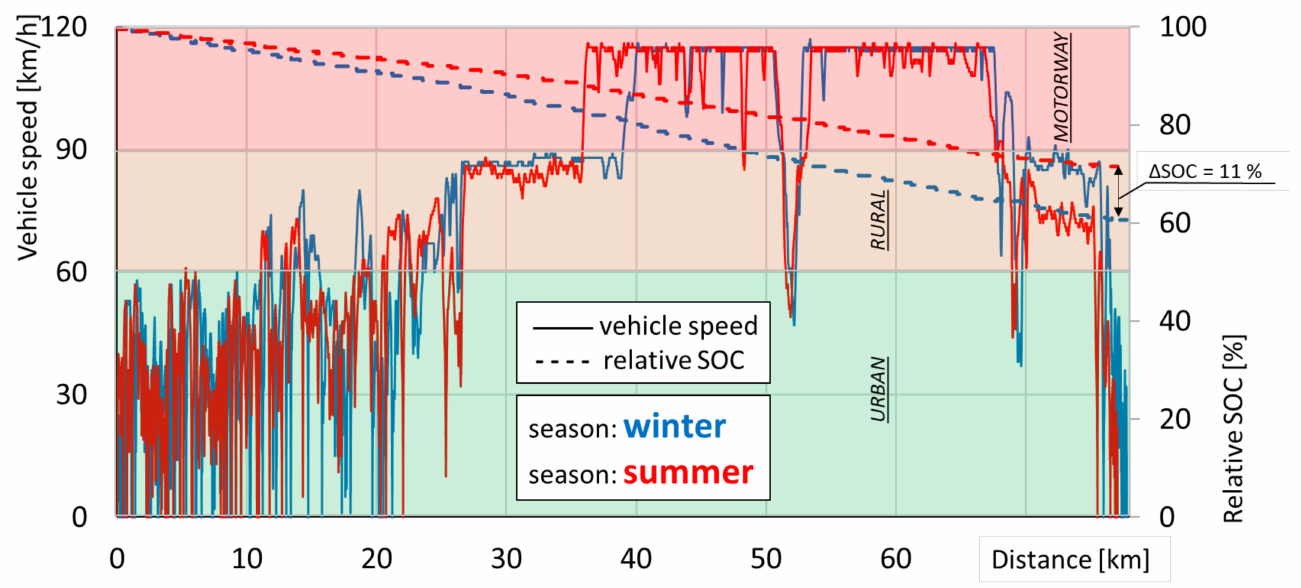
Figure 10. Comparison of the real driving conditions (RDC) test for the performed test runs in winter and summer conditions.